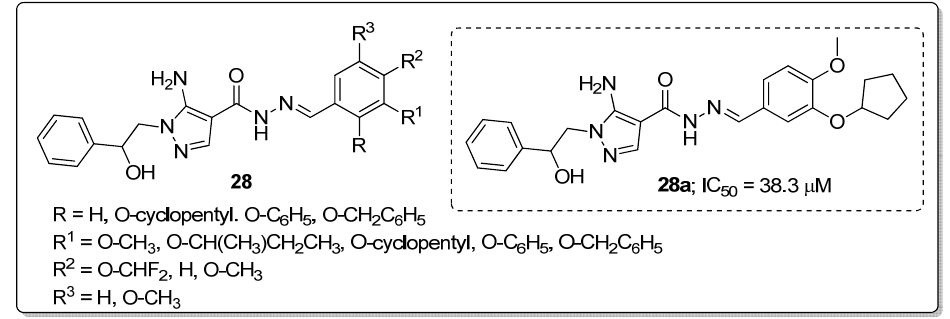
Figure 32. ROS inhibitory activity of the most active pyrazole conjugate 28a .